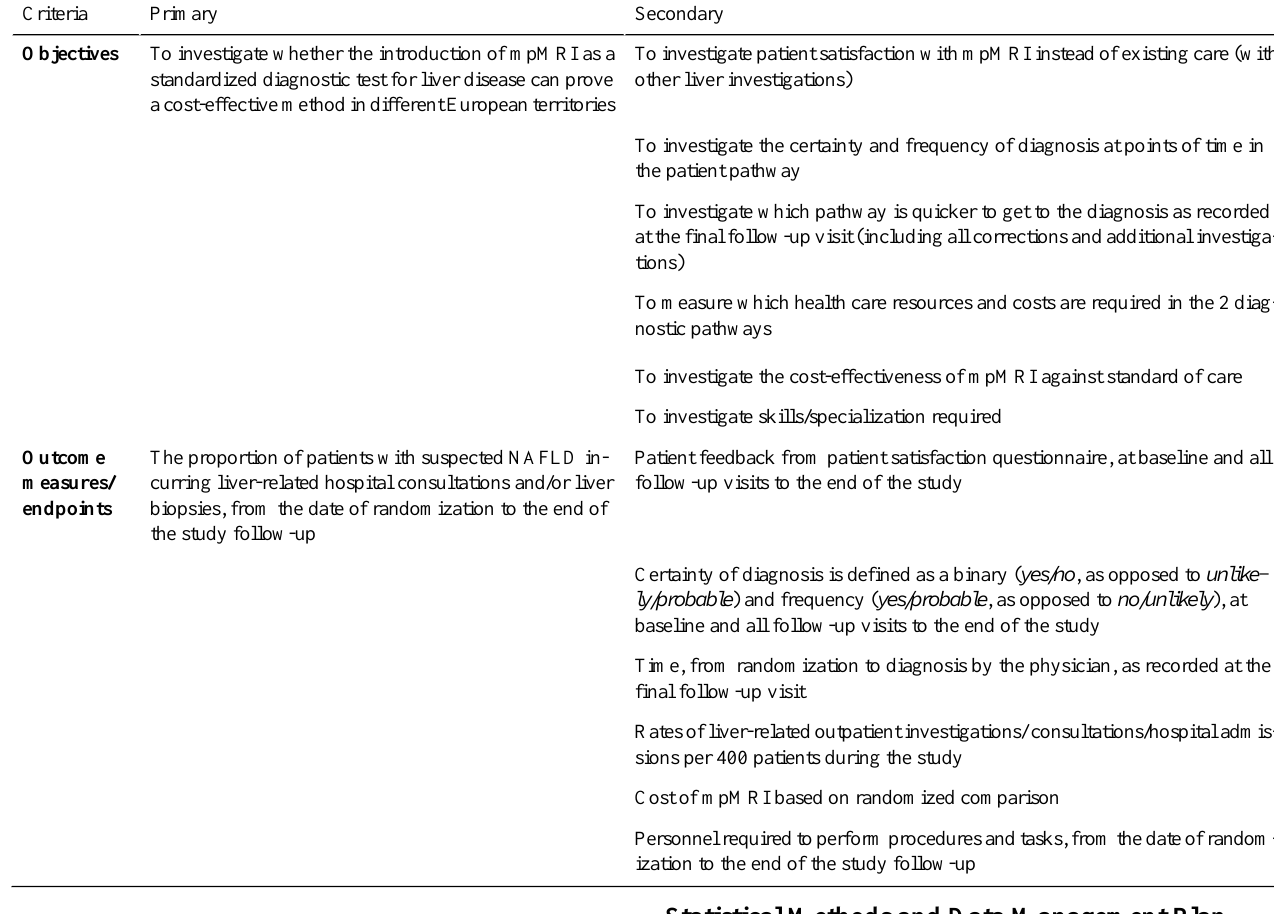
Table 1. RADIcAL1 primary and secondary